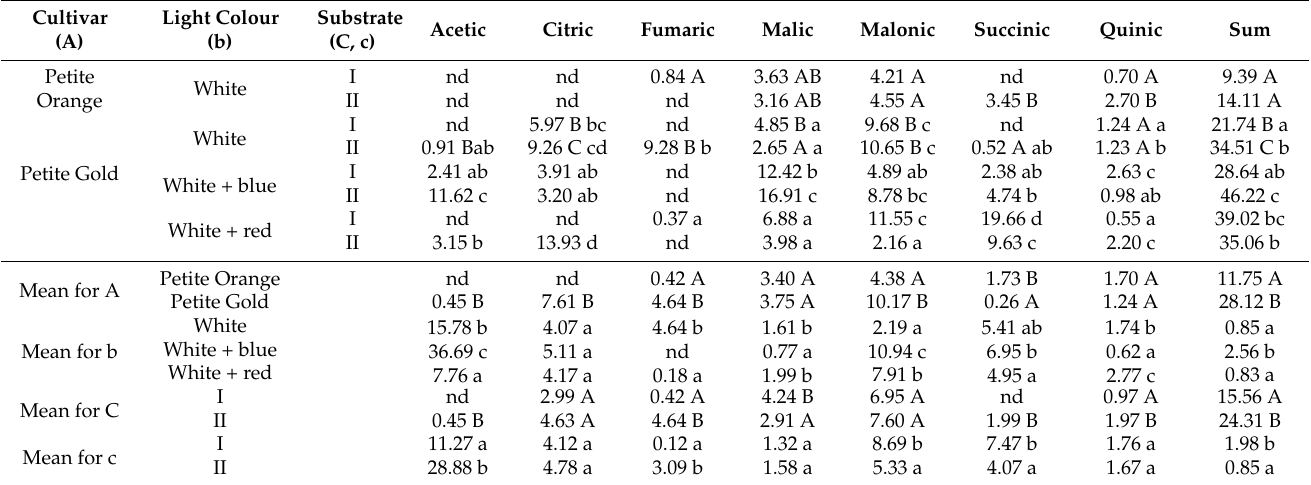
Table 5. Profiling of organic acids of the Tagetes patula flowers depending on cultivar and substrate under white light (big letters) and profiling of organic acids of the Tagetes patula ‘Petite Gold’ flowers depending on light colour and substrate (small letters) [ µ g · g − 1